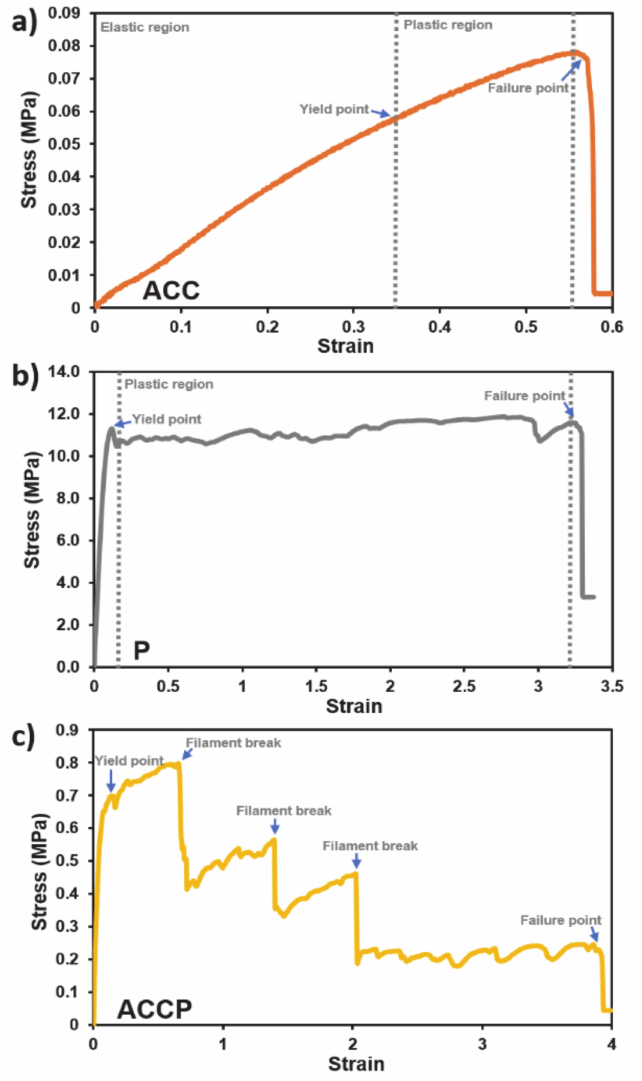
Figure 6. Tensile behavior of analyzed ( a ) ACC, ( b ) P, and ( c ) ACCP 3D printed specimens. Distinct transition regions of the stress-strain curve are clearly marked, whereas the arrows indicate either the yield or failure points, for individual